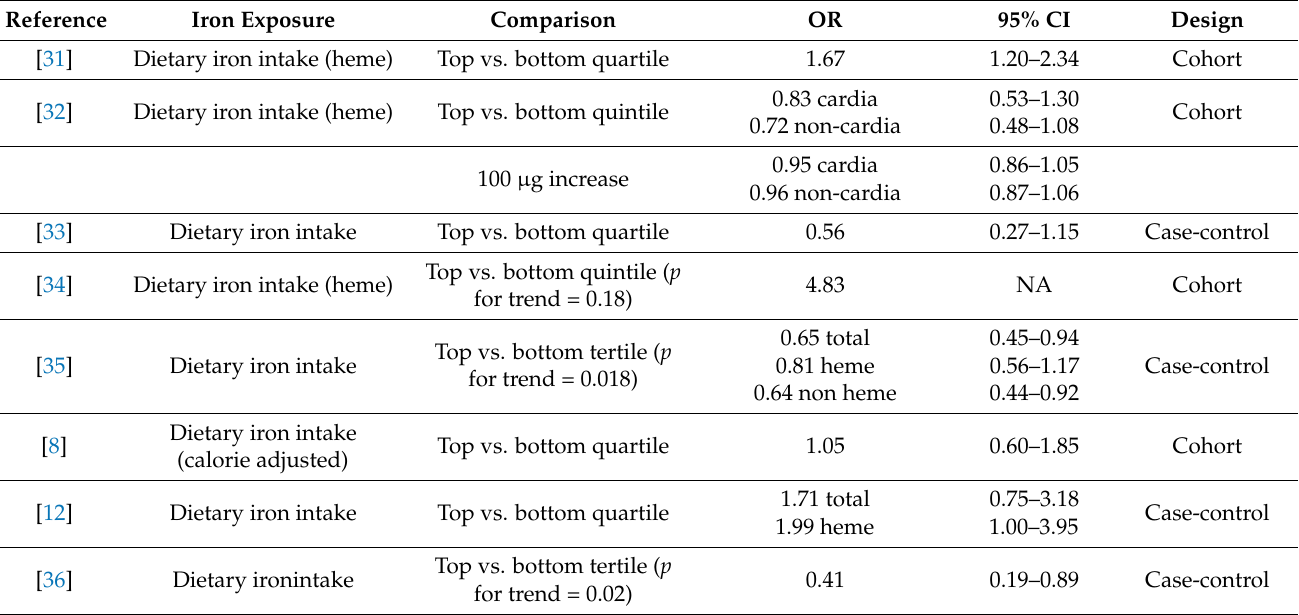
Table 4. Selected other published studies on dietary iron and GC